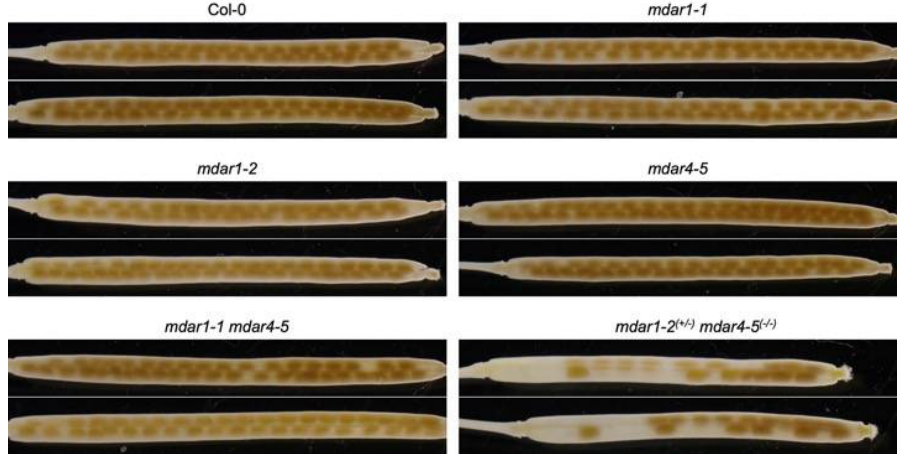
Figure 5. Phenotype of siliques from Arabidopsis thaliana mutants with T-DNA insertions in their AthMDAR1 and 4 genes. The siliques from 6-week-old Arabidopsis thaliana wild-type, mdar1-1 , mdar1-2 , mdar4-5 , mdar1-1 mdar4-5, and mdar1-2 (+/−) mdar4-5 (−/−) plants were decolorized with 100% ethanol and photographed. Representative images are presented.